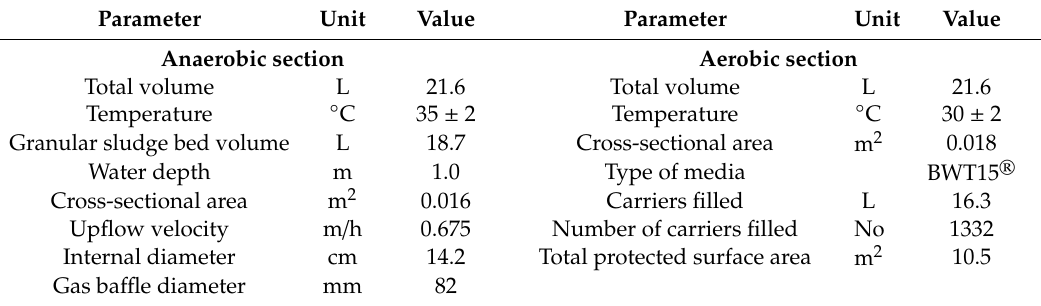
Figure 4. Layout of the HyVAB reactor setup and image of the carrier used in HyVAB [21]. Table 1. HyVAB reactor design parameters and operational conditions.